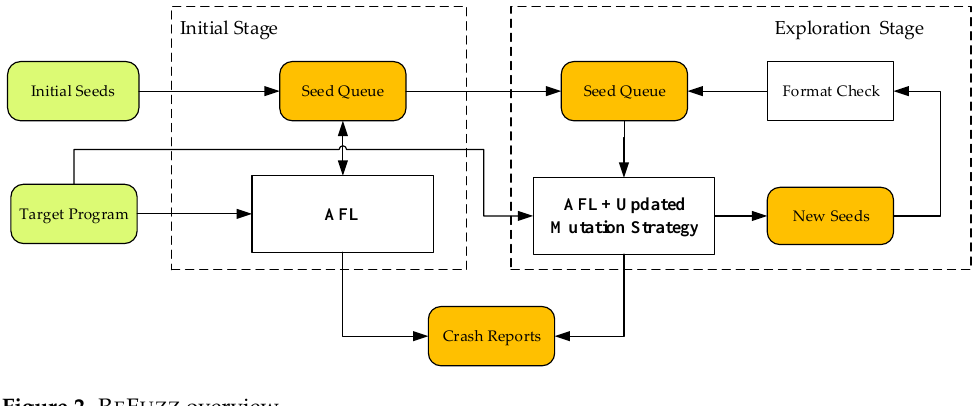
Figure 2. R E F UZZ